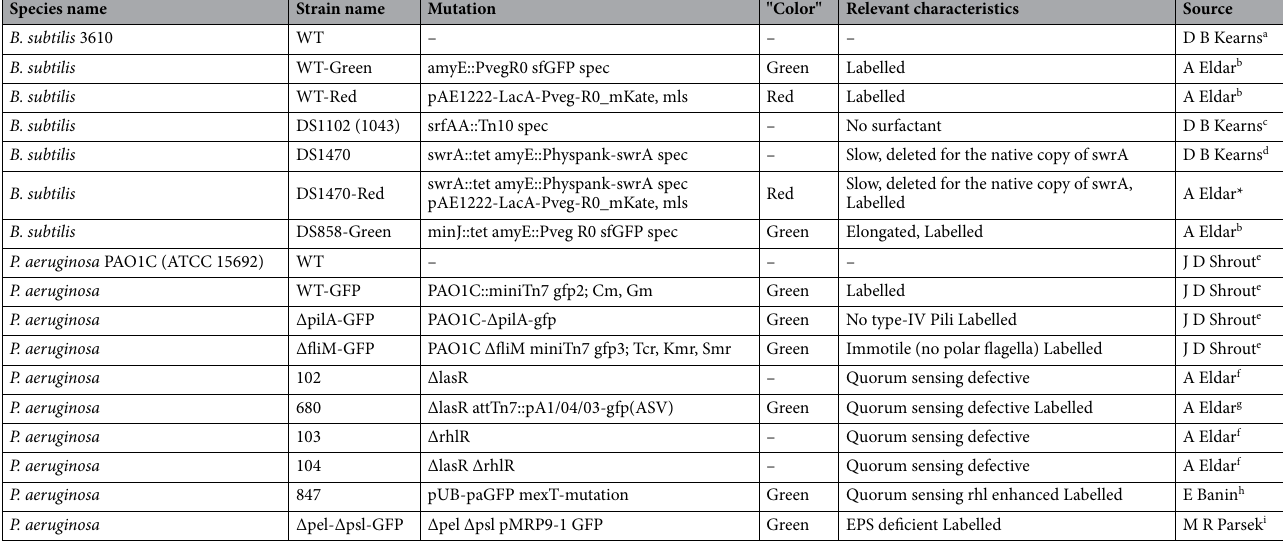
Table 1. A list of all strains used in this work, their main feature, and origin. *This work, courtesy of A Eldar. a Kearns. Nat Rev Microbiol. 8, 634–644 (2010). b Peled et al. PRE. 103, 032413 (2021). c Kearns et al. Mol Microbiol. 52, 357–369 (2004). d Ilkanaiv et al. PRL. 118, 158002 (2017). e Anyan et al. PNAS. 111, 18013–18018 (2014). f Davies et al. Science. 280, 295–298 (1998). g Xavier et al. Mol. Microbiol. 79, 166–179 (2011). h Oshri et al. ISME J. 12(10), 2458–2469 (2018). i Colvin et al. Environ. Microbiol. 14(8), 1913–1928